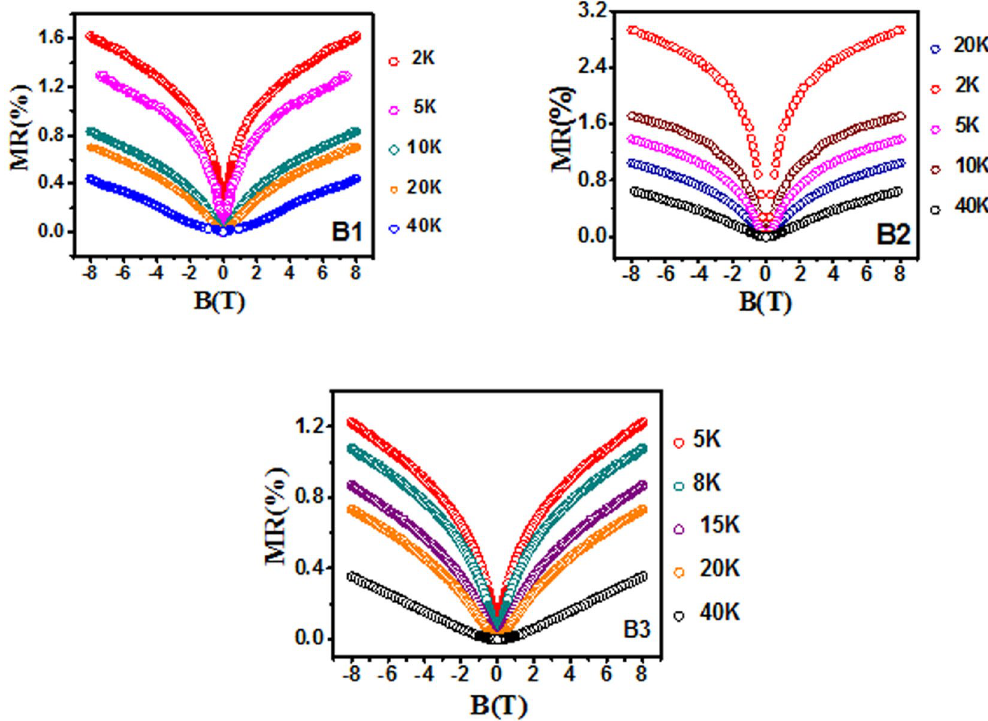
Figure 3. Magnetoresistance (MR) measured at different temperatures for the film B1, B2 and B3 thin films. A sharp rise in MR around zero field (WAL) at lower temperatures is clearly seen in the above plots. B3 owing to metallic nature has the WAL cusp relatively less pronounced in comparison to B1 and